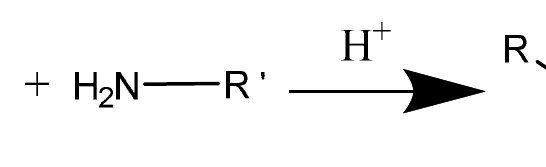
Scheme 6. Ring-opening reaction of aziridine with